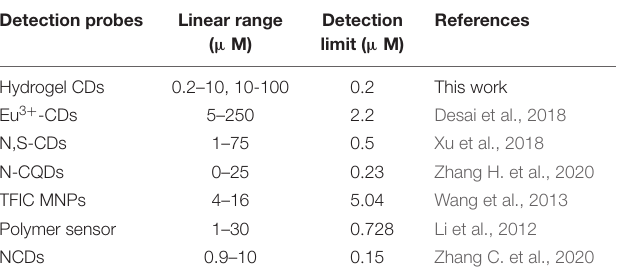
TABLE 4 | Detection limit and linear range of Hg 2 +